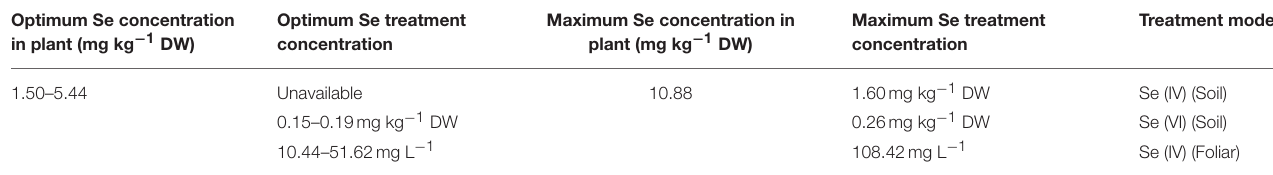
TABLE 4 | Estimated optimum and maximum Se treatment concentrations for different treatment modes based on the optimum (55–200 µ g) and maximum (400 µ g) daily Se intake for adults from fleshy turnip roots (0.345kg fresh